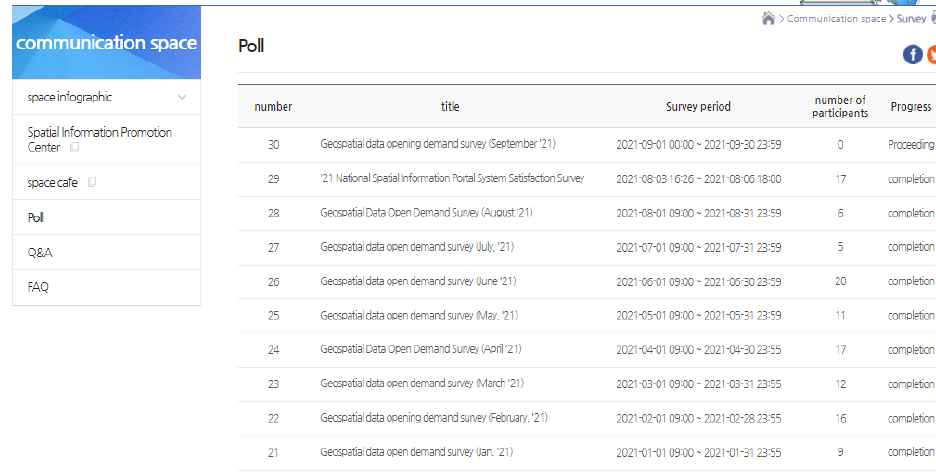
Figure 10. User opinion recruitment on ‘poll’.